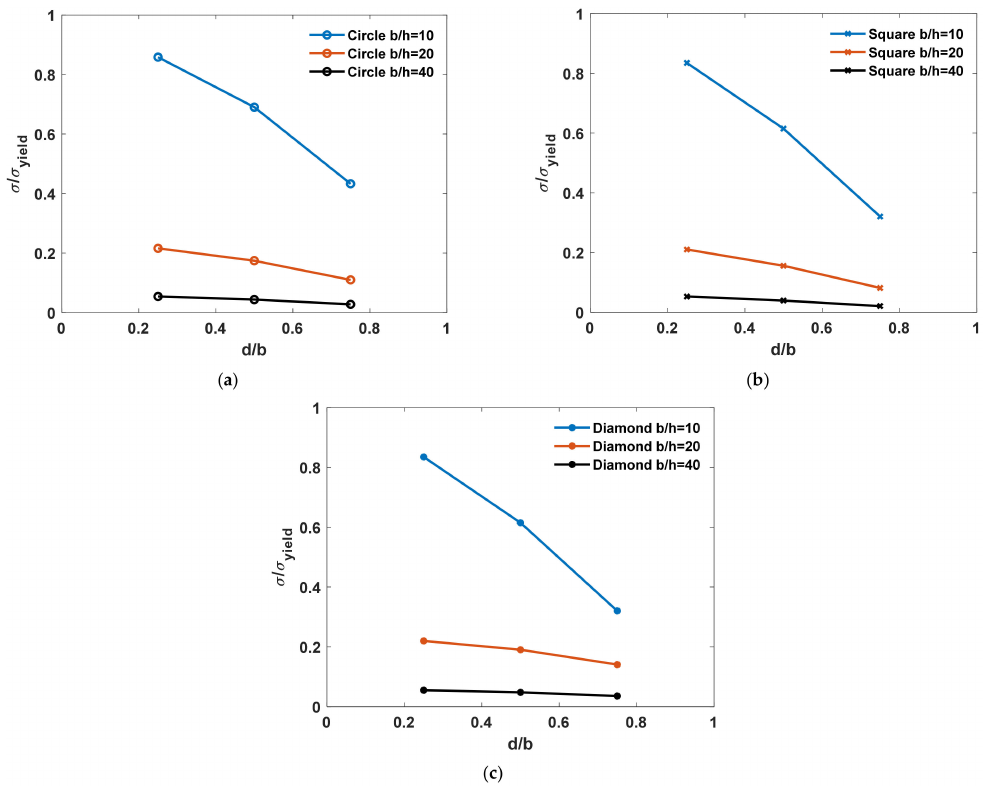
Figure 16. The variation of the opening’s aspect ratio on the normalized stress ratio for ( a ) circle, ( b ) square, and ( c ) diamond openings.